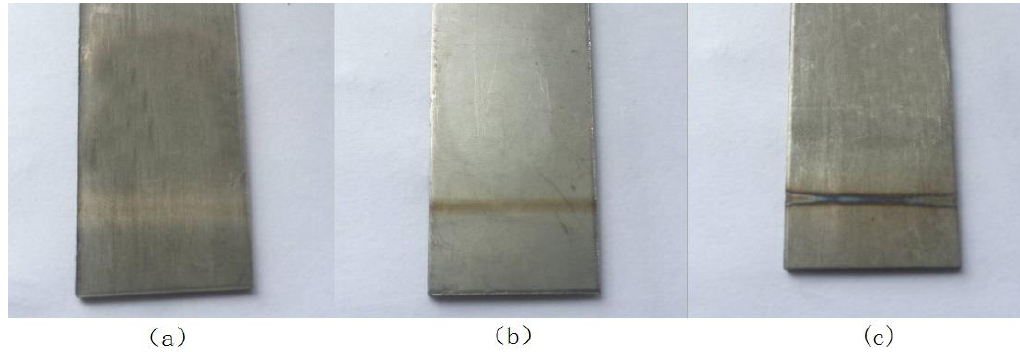
Figure 2. Surface morphology of titanium alloy after treatment by surface treatment power ( a ) 40, ( b ) 50, and ( c ) 60 W.